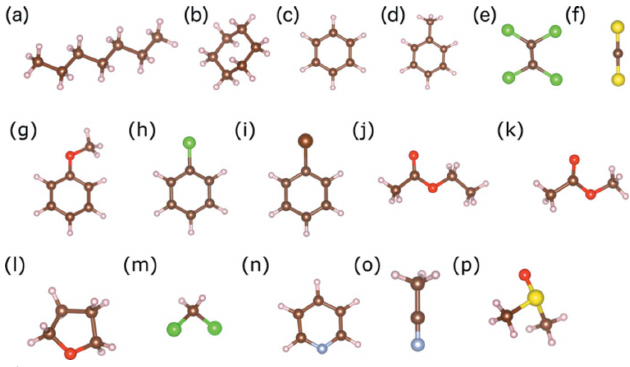
Figure 1 The guest molecules crystallized with TBC6 in this work, arranged in order of increasing polarity: ( a ) n -heptane, ( b ) cyclohexane, ( c ) benzene, ( d ) toluene, ( e ) tetrachloroethylene, ( f ) carbon disulfide, ( g ) anisole, ( h ) chlorobenzene, ( i ) bromobenzene, ( j ) ethyl acetate, ( k ) methyl acetate, ( l ) tetrahydrofuran (THF), ( m ) dichloromethane (DCM), ( n ) pyridine and ( o ) dimethyl sulfoxide